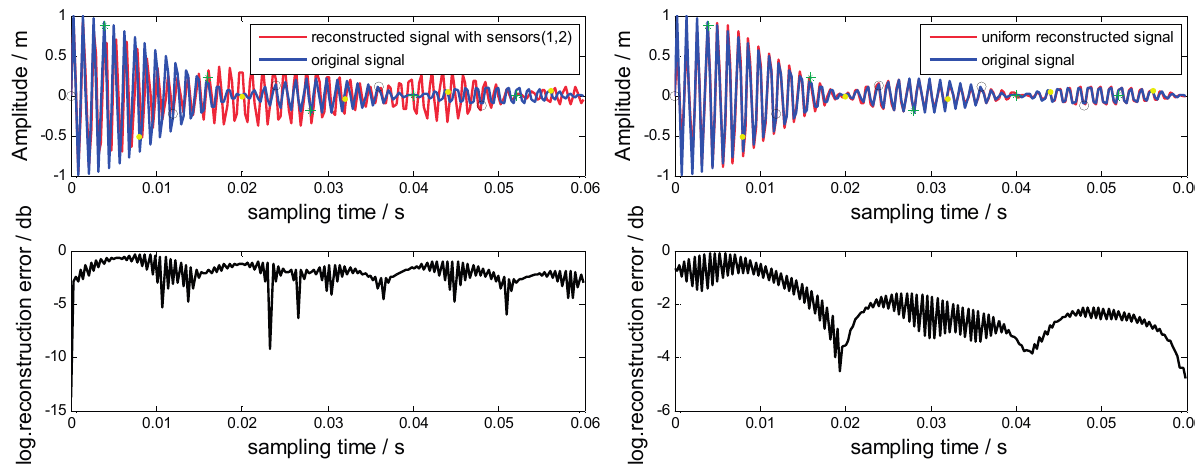
Figure 11. Reconstructed signals and the original signal with 800 Hz.